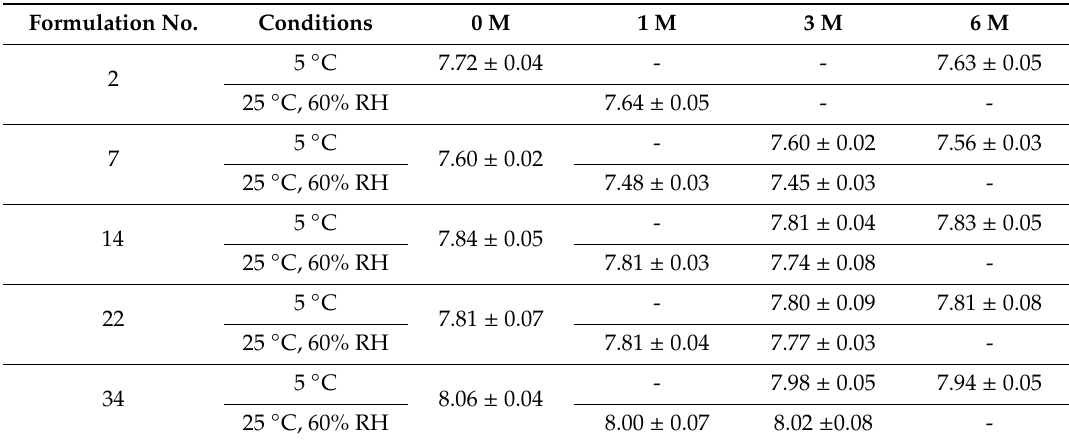
Table 5. pH of solution after reconstitution of lyophilized formulations. Formulation No.